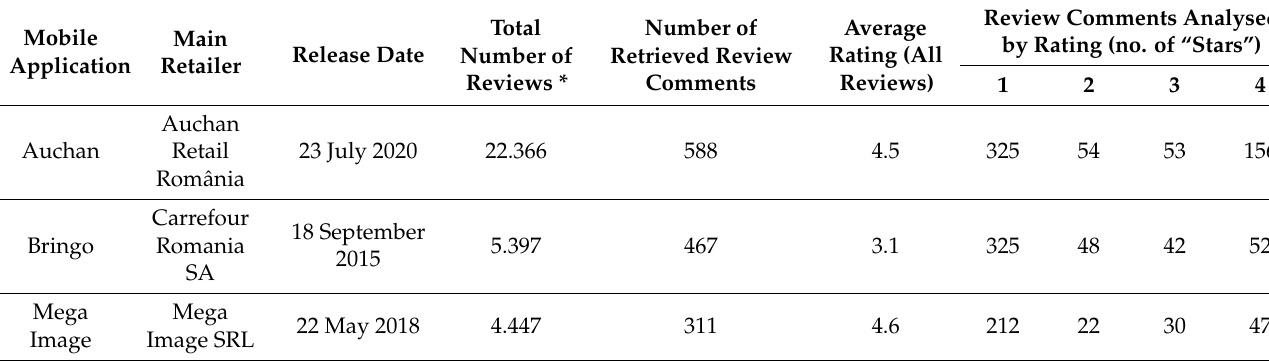
Table 1. Details of the MGSAs